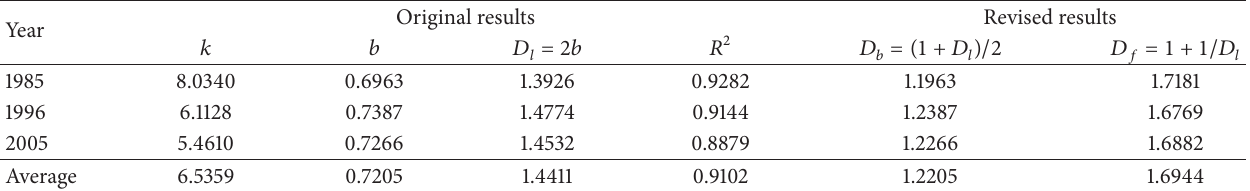
Table 2: The global fractal parameters of the cities and towns in Yangtze River Delta, China